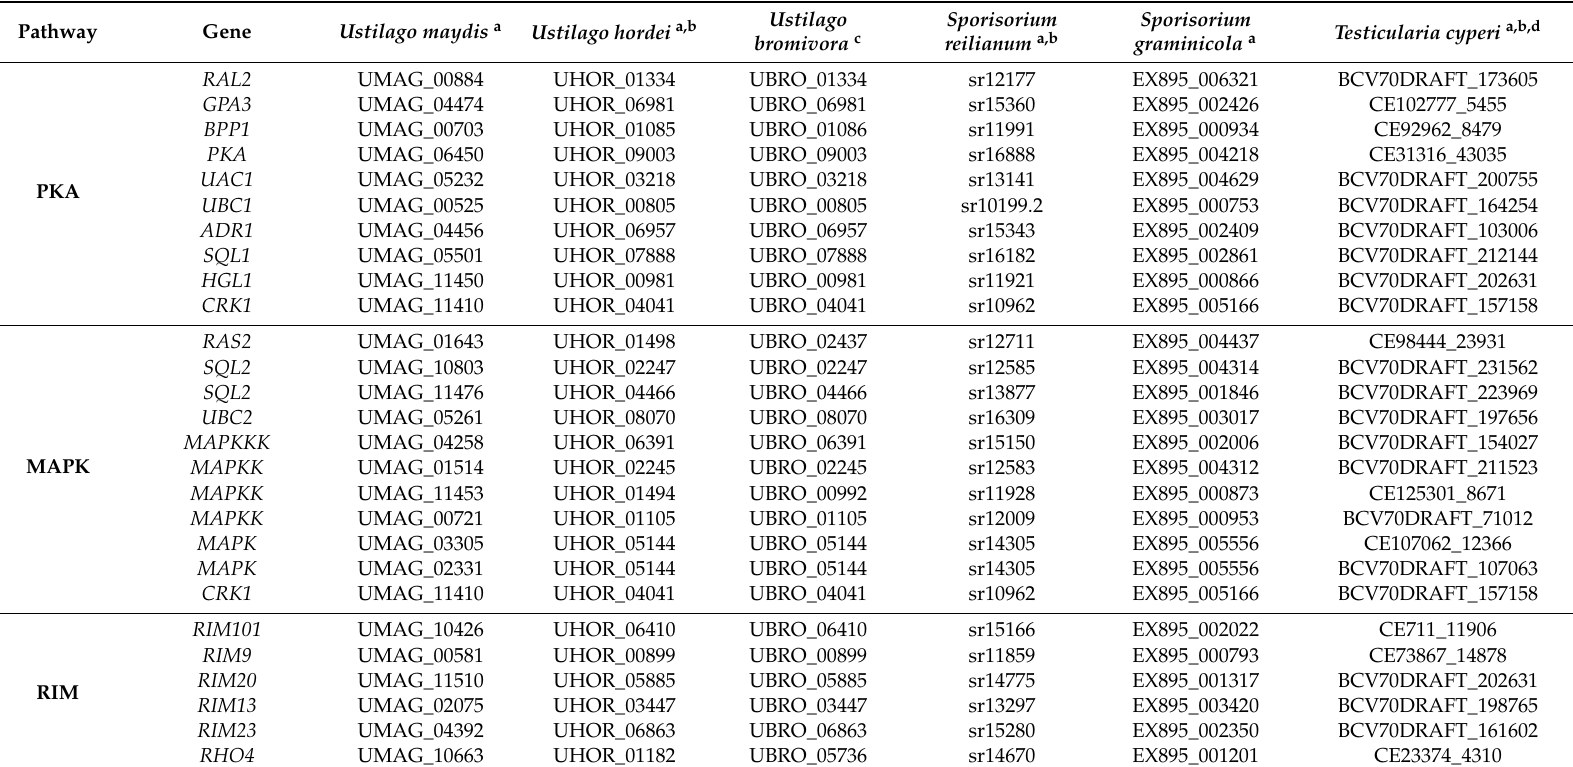
Table 1. Signal transduction pathways related to the multicellular growth of